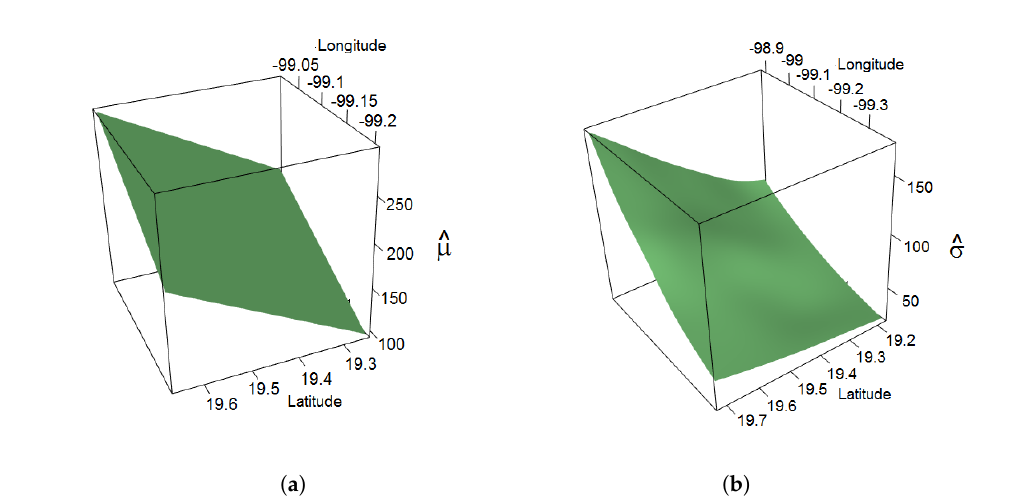
Figure 5. Estimated spatial smoothing of the ( a ) location parameter and ( b ) scale parameter in the year